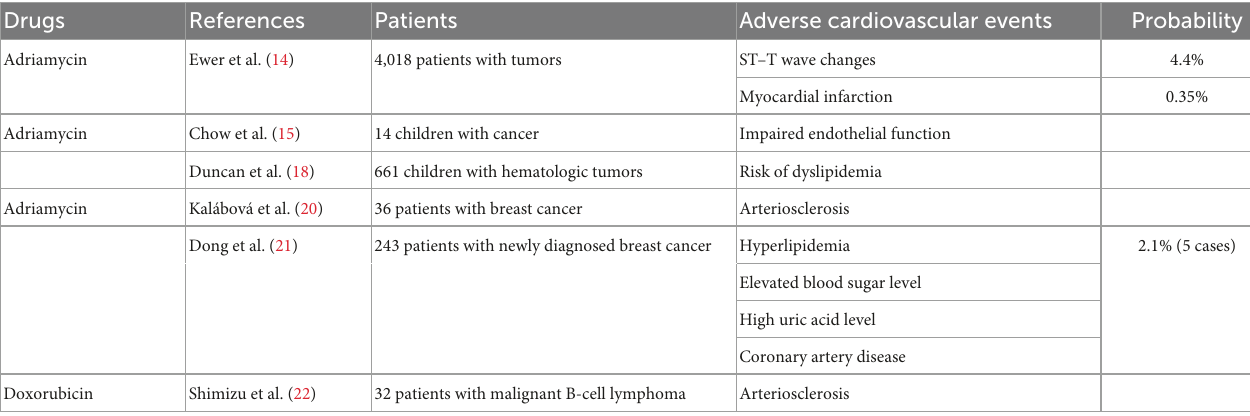
TABLE 1 Overview of clinical studies on cardiovascular toxicity of anthracyclines. Drugs